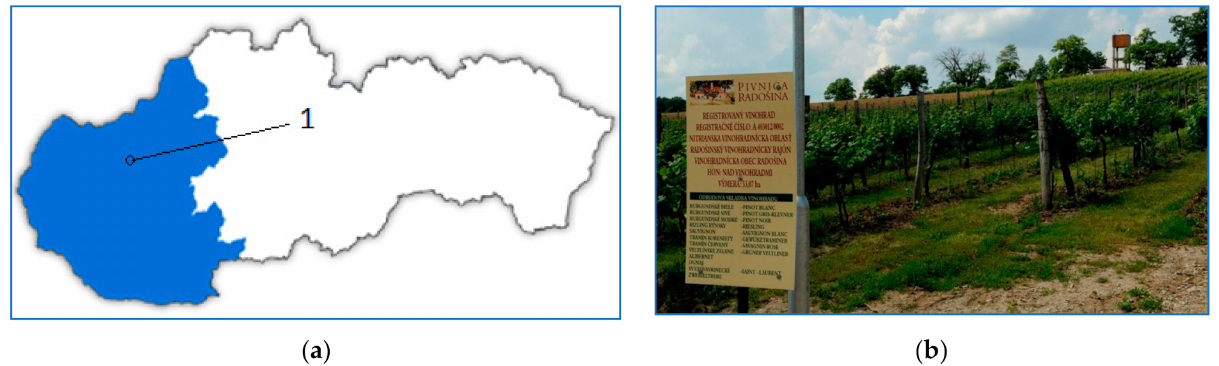
Figure 1. Map of the area of interest, with 1 denoting the location of the vineyards (right, cellar, 2020): ( a ) Description of study area with specific region highlights; ( b ) Detailed picture of study area of